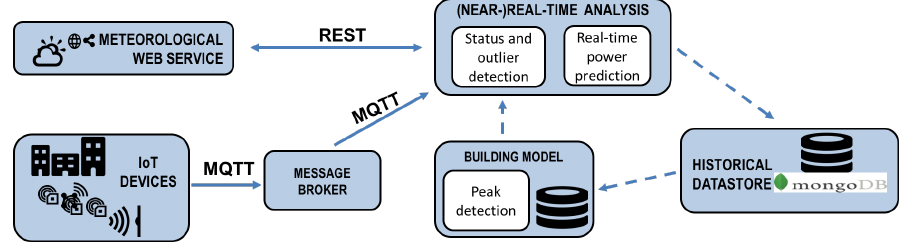
Figure 2. Software infrastructure